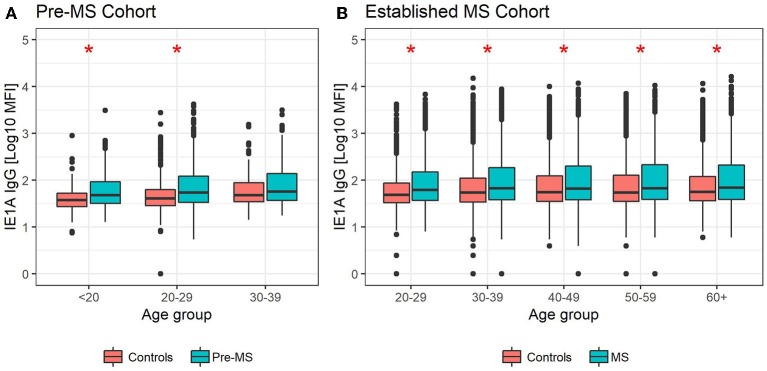
Median MFI response against HHV-6A IE1A protein in different age groups. Median of median fluorescence intensity (MFI) in different age groups for (A) pre-MS cohort (n = 478 persons who later developed MS and n = 476 controls) and (B) established MS cohort (n = 8,394 persons with MS and n = 7,214 controls). Statistics were calculated with linear regression. Significant (p < 0.008) differences in IgG levels between MS cases and controls within each age group are indicated with *.